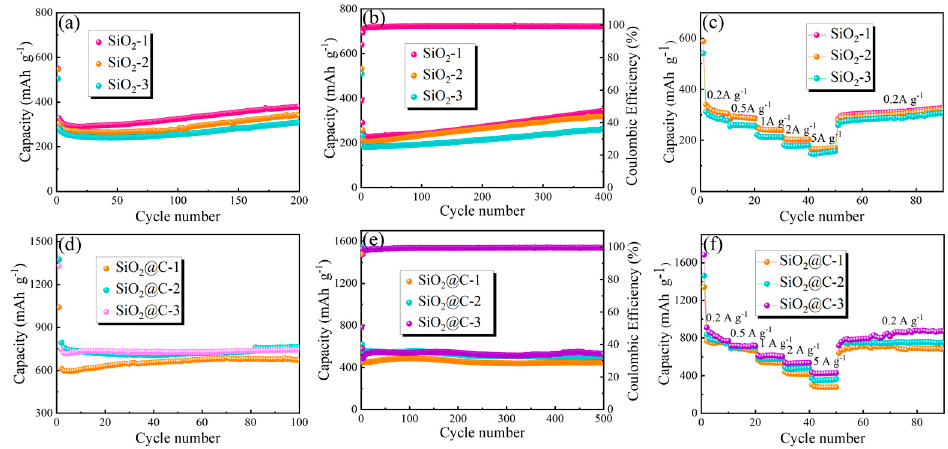
Figure 5. SiO 2 : ( a ) cycling performances at a current density of 0.2 A g − 1 , ( b ) cycling performances at a current density of 1 A g − 1 , and ( c ) rate performances. SiO 2 @C: ( d ) cycling performances at a current density of 0.2 A g − 1 , ( e ) cycling performances at a current density of 1 A g − 1 , ( f ) rate performances.